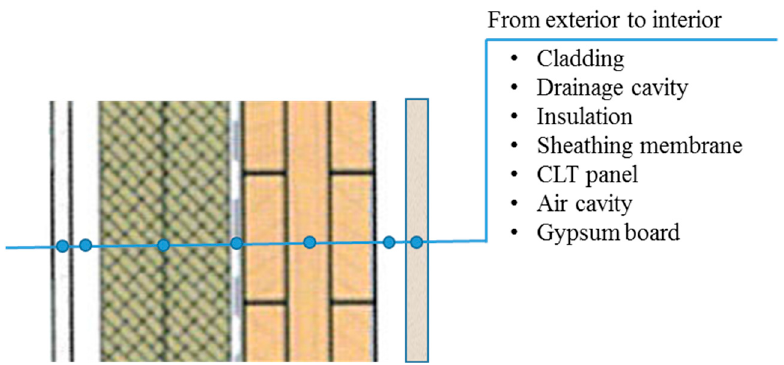
Figure 1. Composition of the cross ‐ laminated timber (CLT) wall considered in this study.